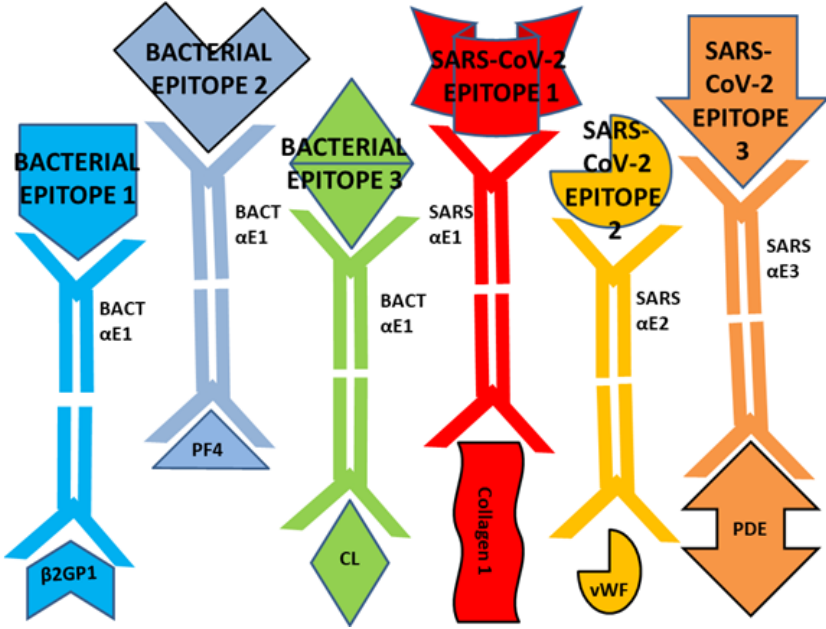
Figure 15. Antibodies against bacterial epitopes (BACT αE1, αE2, αE3)— in blues and greens- and antibodies against viral epitopes (SARS α E1, SARS α E2, SARS α E3)—in oranges and reds—cross- react with human blood proteins due to mimicry between their proteins: β2GPI = β2glycoprotein1; PF4 = platelet factor 4; CL = cardiolipin; vWF = von Willebrand Factor; PDE = phosphodiesterase.